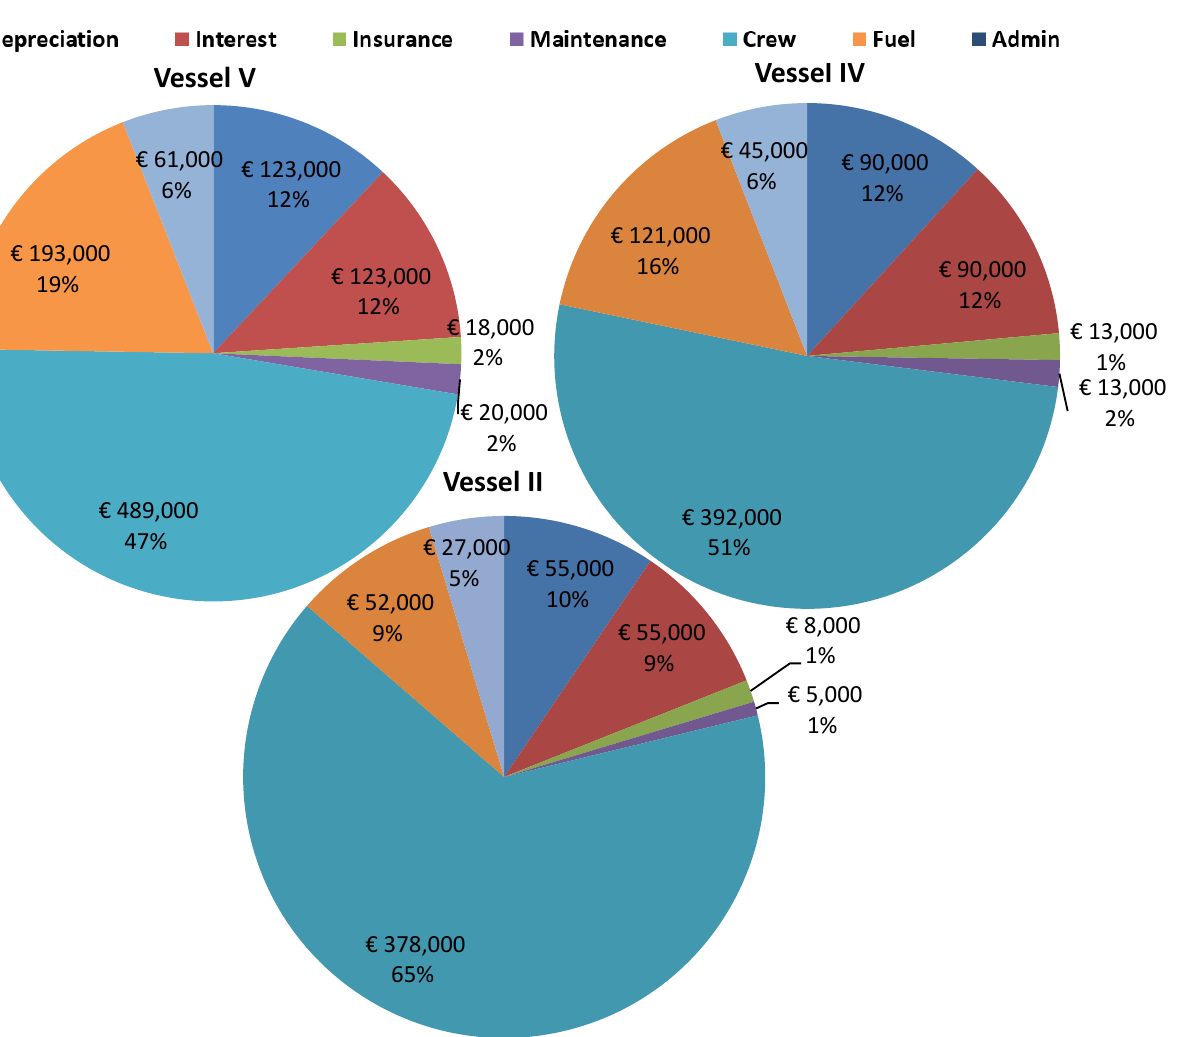
Figure 3: Cost Breakdown under B Operating